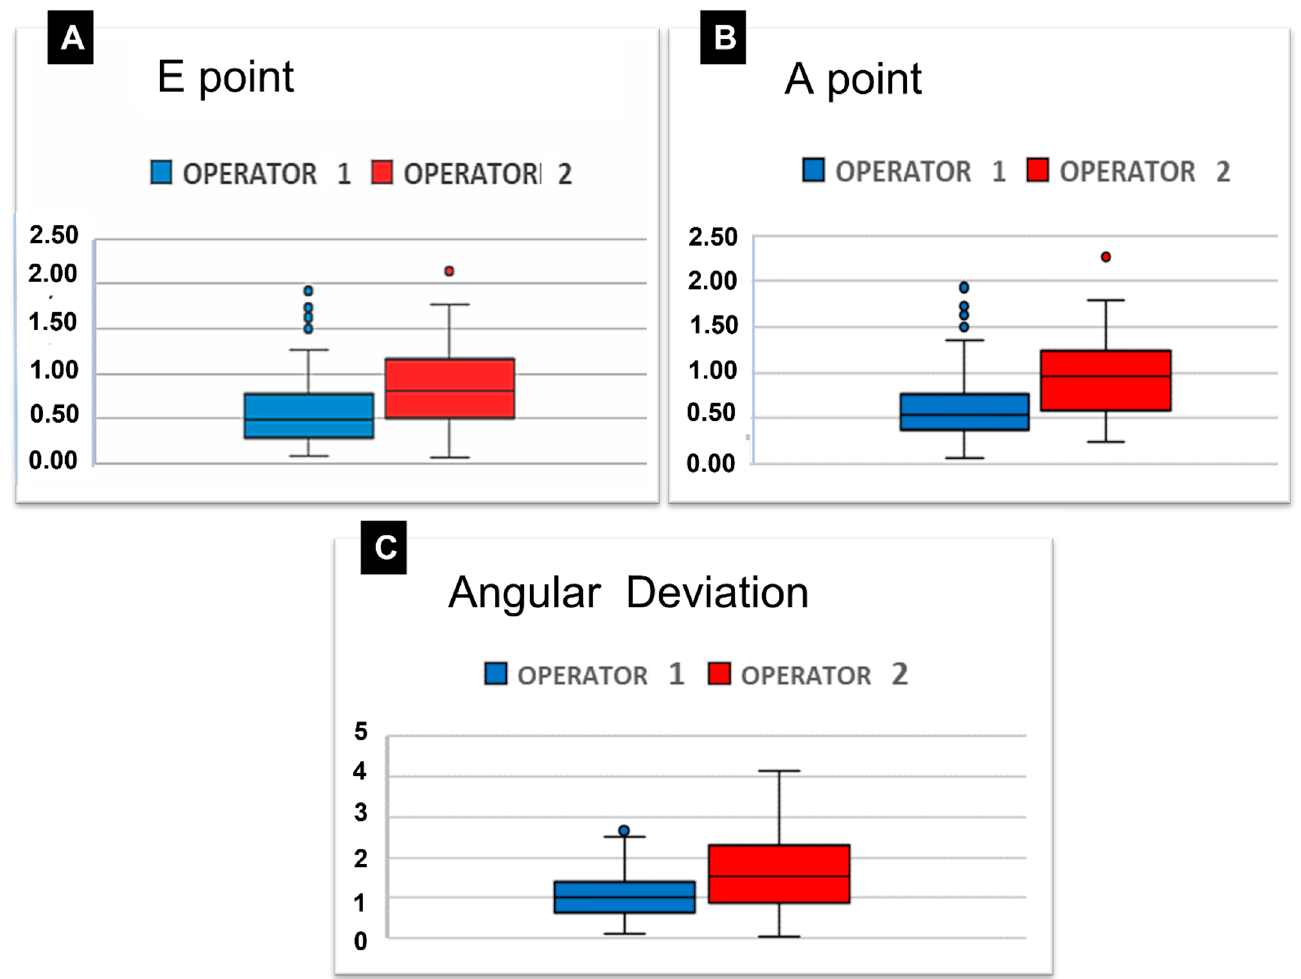
Figure 4. Box-plots showing the comparison of the two operators relative to the mean values from the three methods evaluation for E point ( A ), A point ( B ), and angular deviation ( C ).